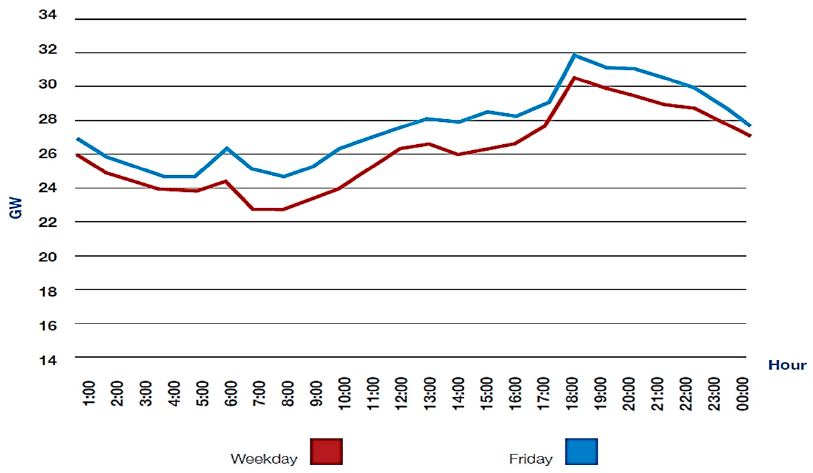
Figure 2. KSA’s typical daily electricity load curve during winter [4].